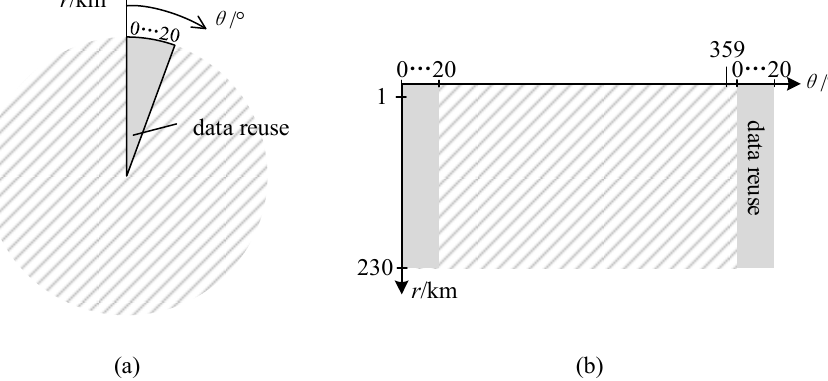
Figure 4. Conversion from a θ -r polar coordinate system to a θ -r rectangular coordinate system: ( a ) Circular data region in a θ -r polar coordinate system and ( b ) rectangular data region in a θ -r rectangular coordinate system. In (b), the azimuth θ is taken as the horizontal axis with the resolution of 1° and radial distance r as the vertical axis with the resolution of 1 km. To prevent the airflow field near the azimuth angle of 0° from being truncated in the θ - r rectangular coordinate system, the coordinate system is extended horizontally by 20 degrees.